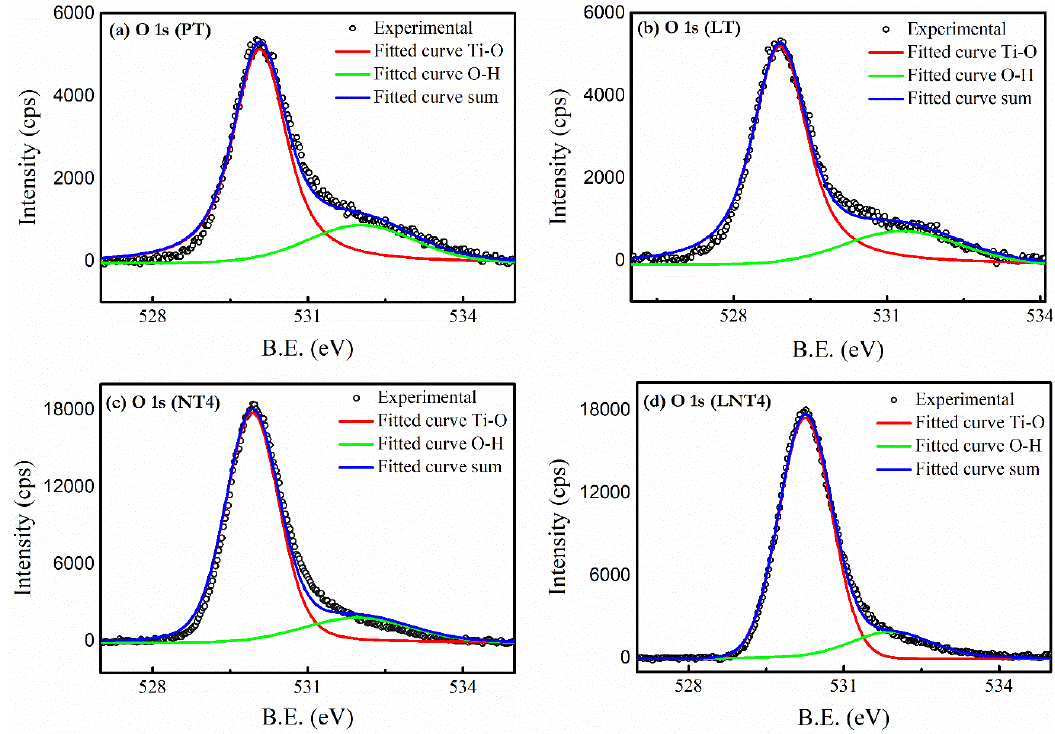
Figure 4. The High resolution XPS spectra of O 1s for ( a ) PT, ( b ) LT, ( c ) NT4 and ( d ) LNT4.